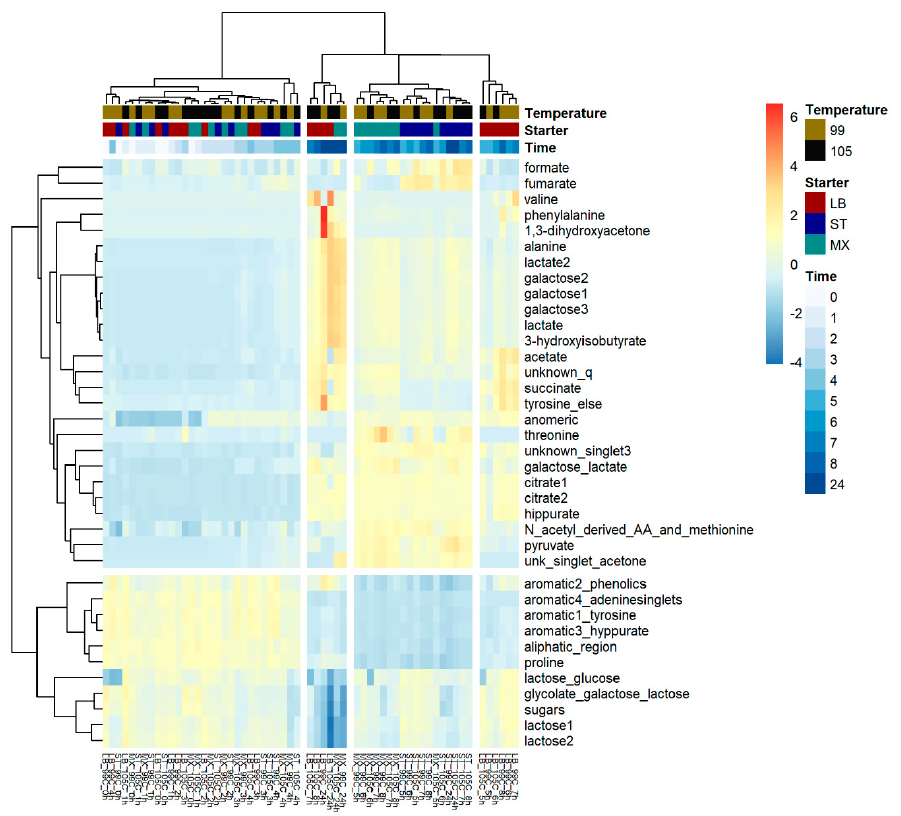
Figure 4. Illustration of hierarchical heatmap clustering of the 37 selected intervals during the fermentation. The experimental design has been emphasized with color-coding. The relative concentration of metabolites is shown with a color gradient from blue (low) to red (high). Spacing in the heatmap shows the significant clusters found according to the gap